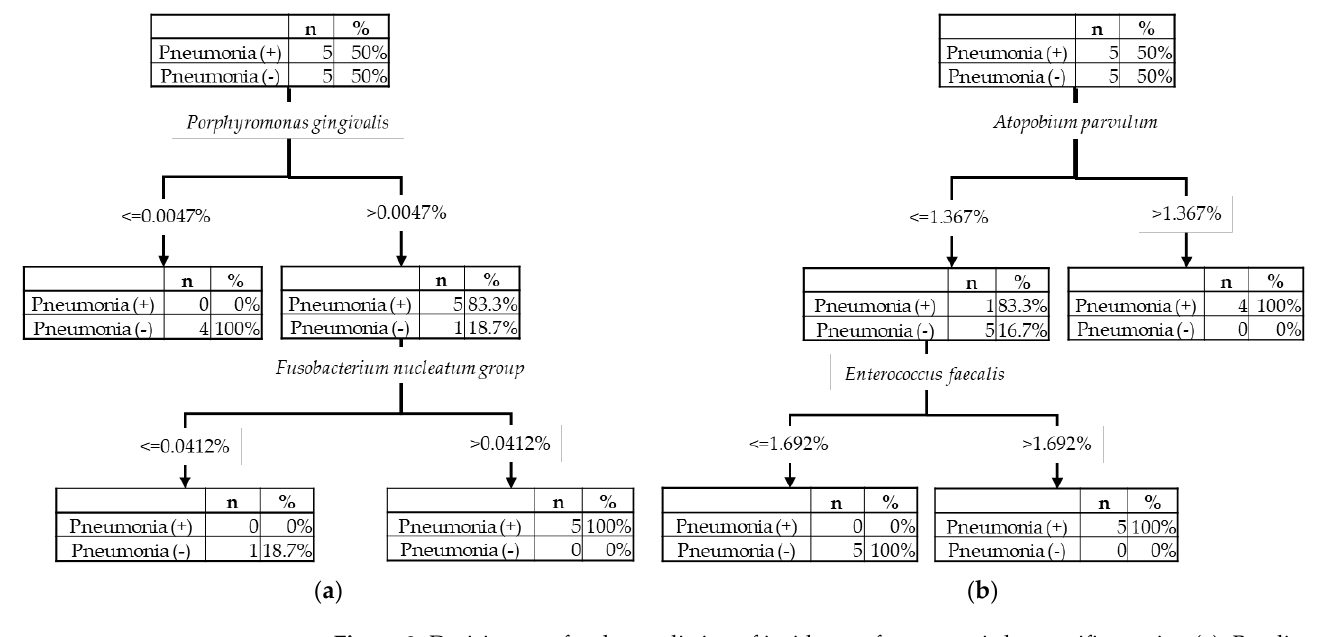
Figure 2. Decision tree for the prediction of incidence of pneumonia by specific species; ( a ): Baseline; ( b ): Before cancer operation. “+”: incidence of pneumonia, “-“: without incidence of pneumonia.